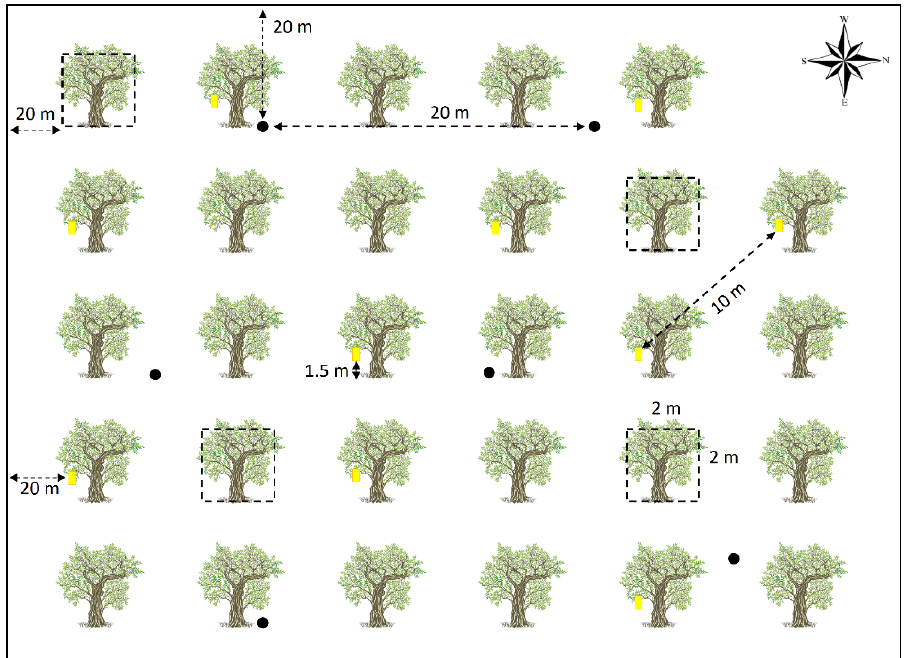
Figure 2. Sampling design. Black circles: pitfall traps; yellow rectangles: sticky traps; empty squares: 2 m × 2 m vacuuming quadrants. Dashed arrows represent the minimum distance between traps or the grove’s edge.